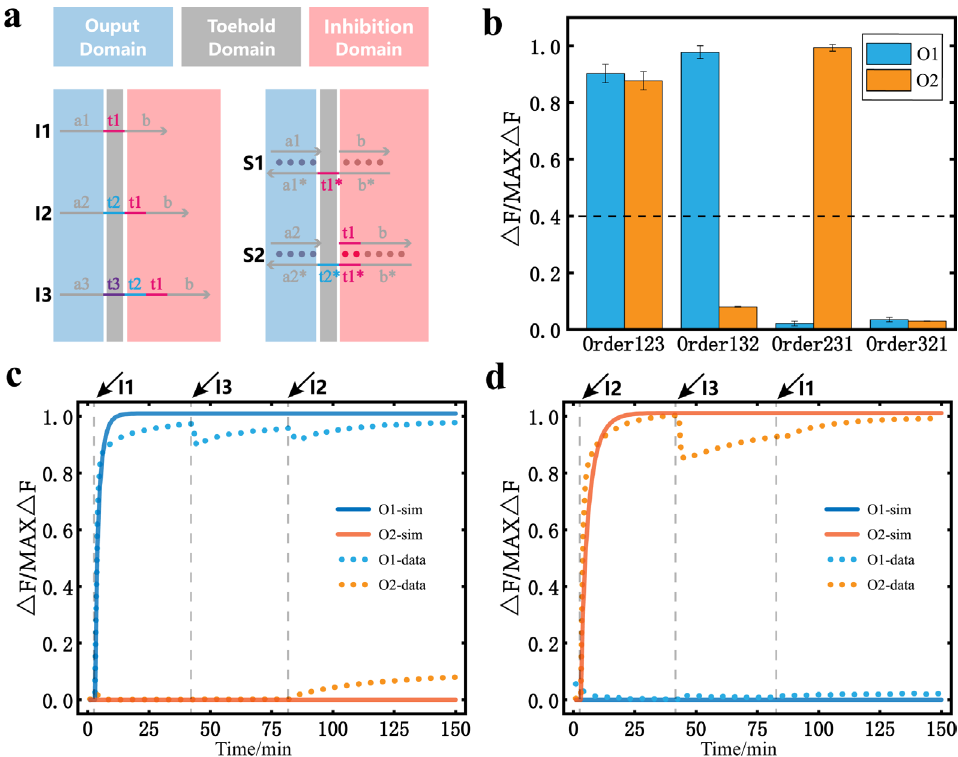
Figure 3. DNA temporal logic circuit with three inputs and two substrates. ( a ) Design of the temporal logic circuit with three inputs and two substrates. ( b ) Bar graph of the output fluorescence signal with different orders of inputs. The dashed line marks the separation between the output results 0 and 1. ( c ) The curve of the fluorescence data and simulation data when the order of in- puts is I1, I3, and I2, and the interval of input addition is 40 min ([S1] = [S2] = [S3] = 120 nM, [I1] =